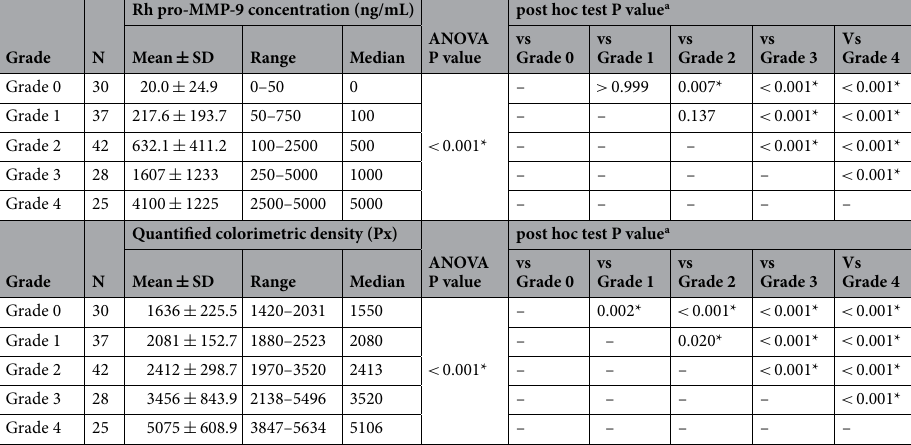
Table 4. Difference of values of recombinant human pro-matrix metalloproteinase 9 (MMP-9) concentration and quantified colorimetric density according to the readout grades based on the 5-scale grading system. SD = Standard deviation. * P < 0.05. a Bonferroni’s post